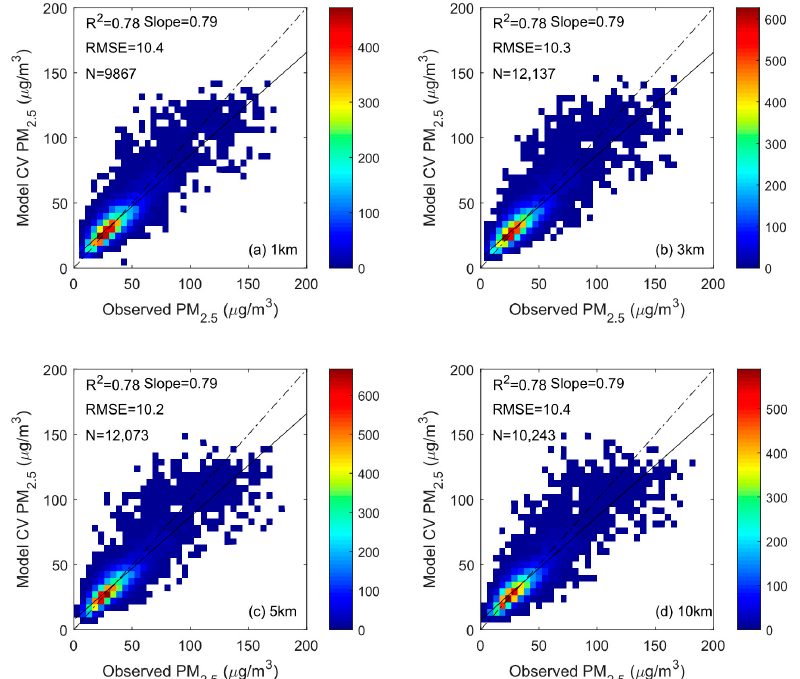
Figure 4. Scatter plots of 10-fold cross validation (CV) results for the mixed effects (ME) model at the resolutions of ( a ) 1, ( b ) 3, ( c ) 5 and ( d ) 10 km. The color bar represents the counts of samples. R 2 , RMSE and N are the coefficient of determination, root-mean-square error and number of samples, respectively. The dashed line stands for the 1:1 line.